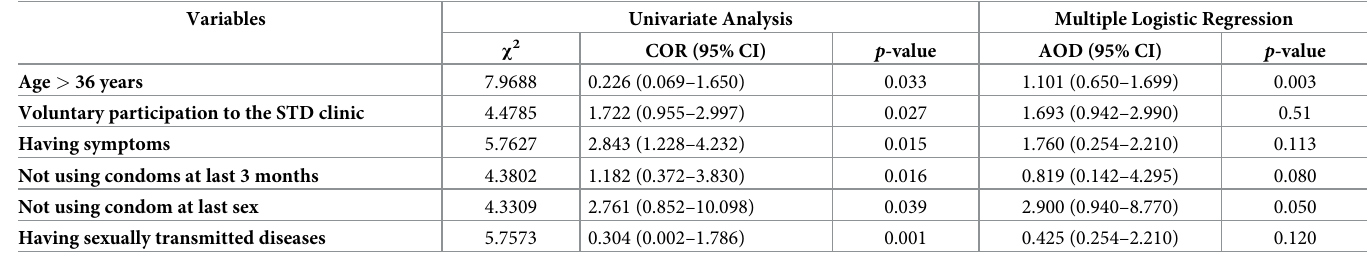
Table 6. Univariate and multiple logistic regression